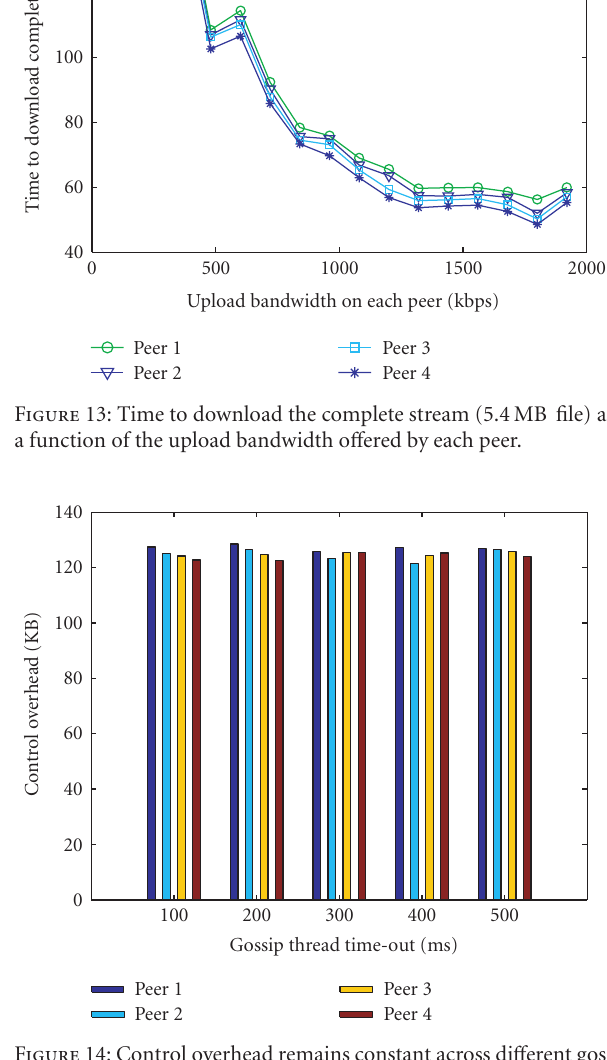
Figure 14: Control overhead remains constant across di ff erent gos- sip thread